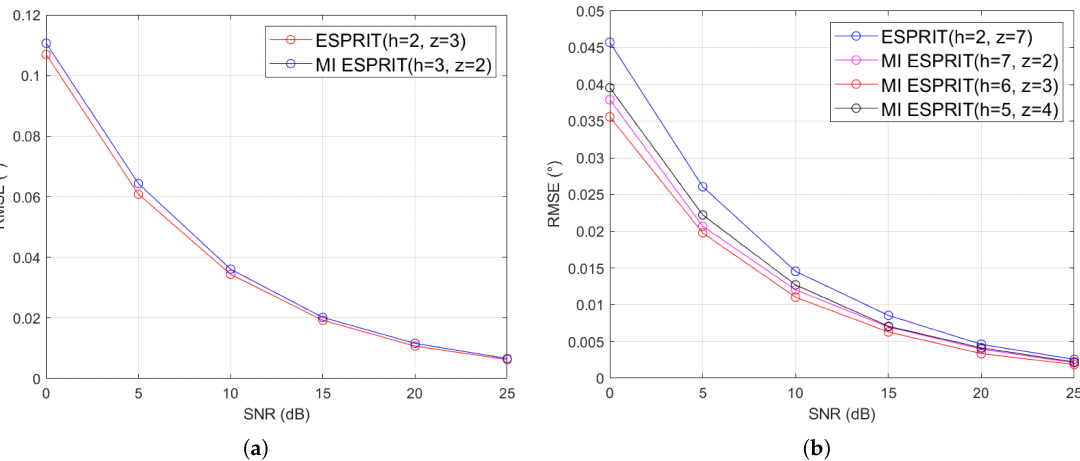
Figure 5. Comparison of RMSE of DOA according to the number of subarrays ( h ) and the number of antennas in subarray ( z ), ( a ) M = 4, ( b ) M =